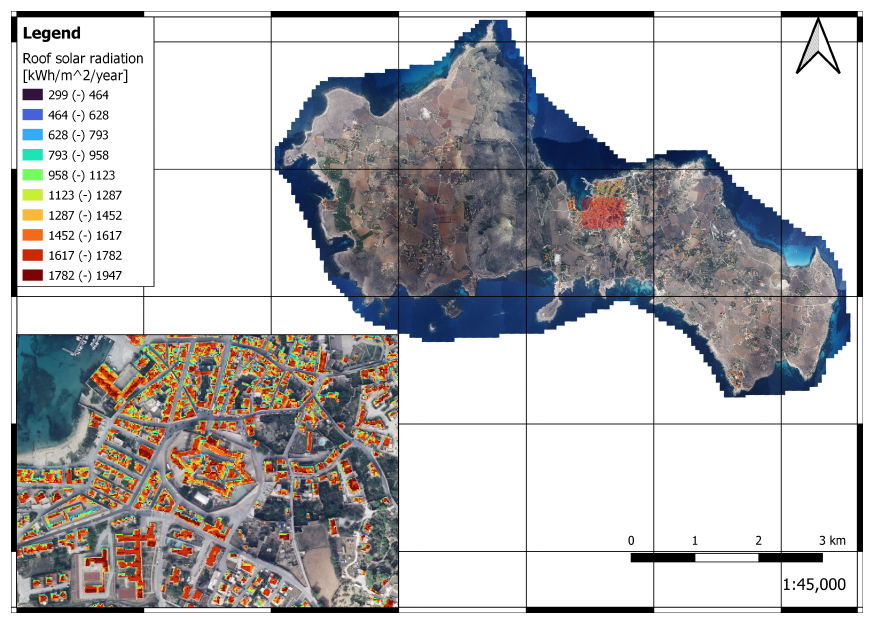
Figure 27. Solar radiation of the city centre of Favignana.